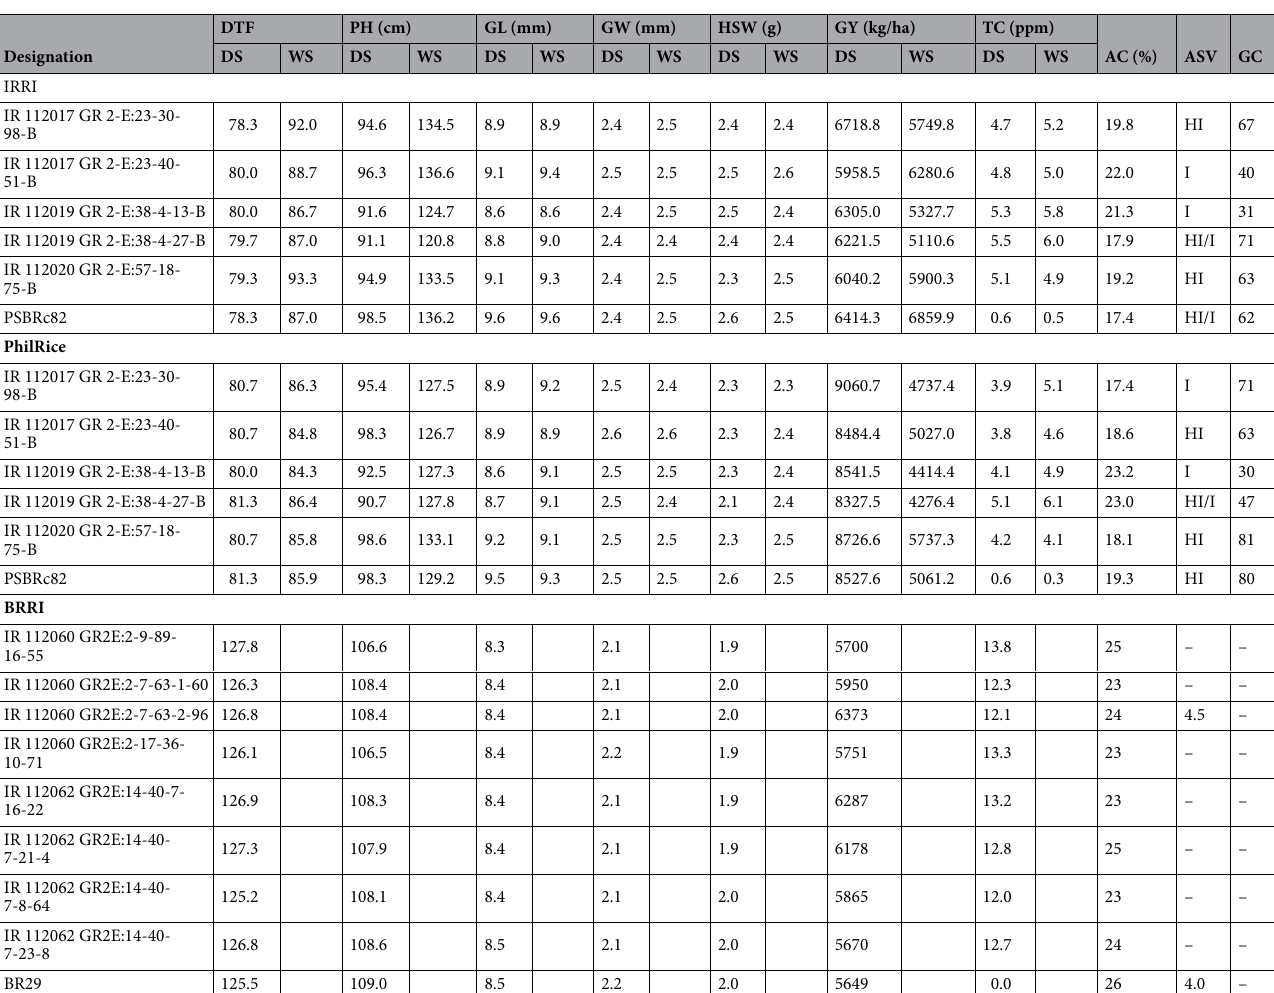
Table 5. Agronomic performance of GR2E lines selected for multi-location evaluation. DTF days to fifty percent flowering, PH plant height, TN Tiller number, PN Panicle number, PL Panicle length, FL flag